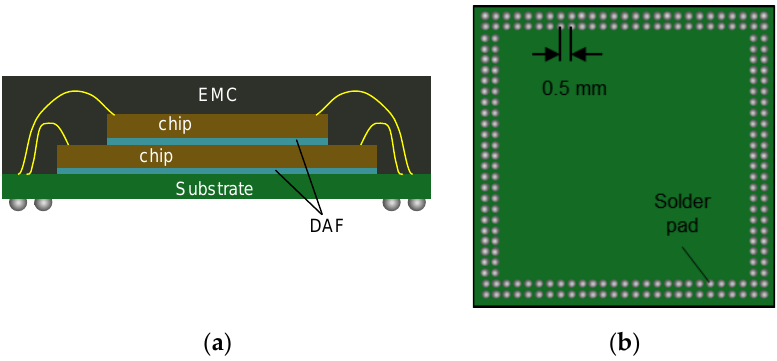
Figure 2. TFBGA package: ( a ) cross-sectional view and ( b ) bottom view.